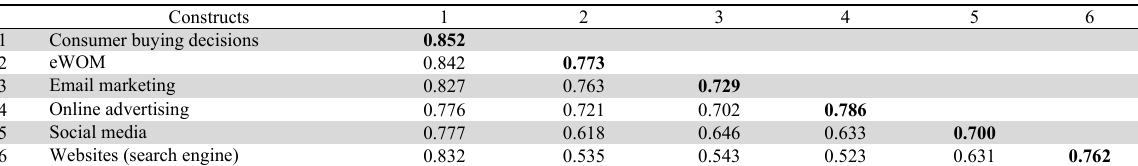
sented in Table 2 and Table 3. The gained results were calculated through the square root the AVE and they stated in the bold off-diagonal cells that they were larger than the variables correlations itself as given in the respective tables (Fornell &